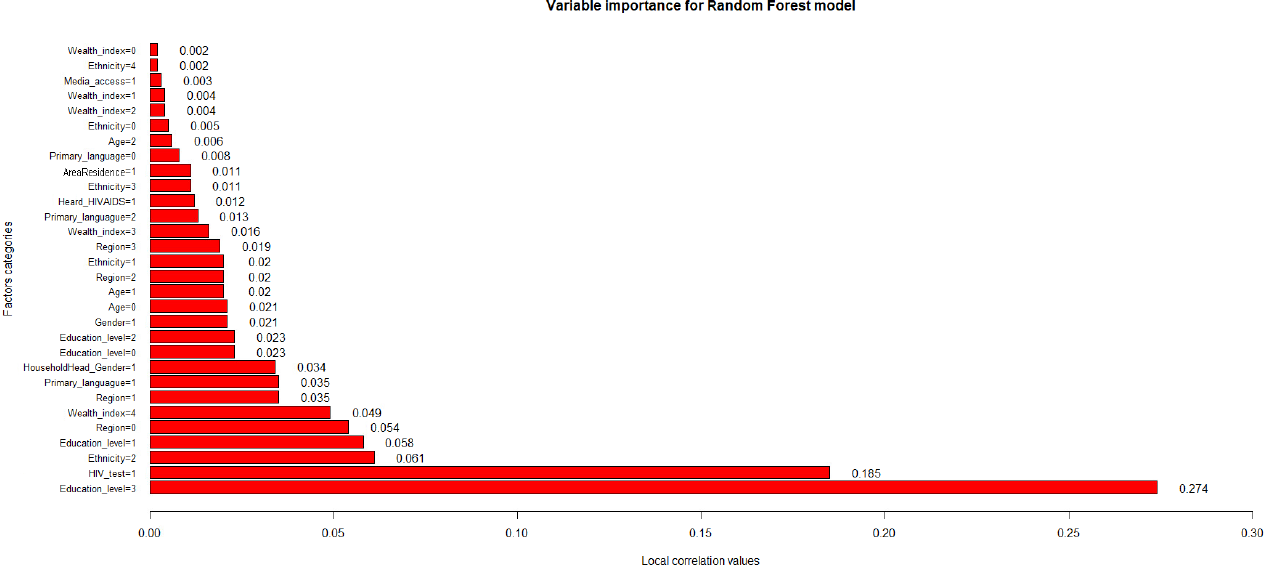
Figure 7. Local correlation values of the independent factor categories related to the prediction of the knowledge about HIV/AIDS in the target population in the random forest